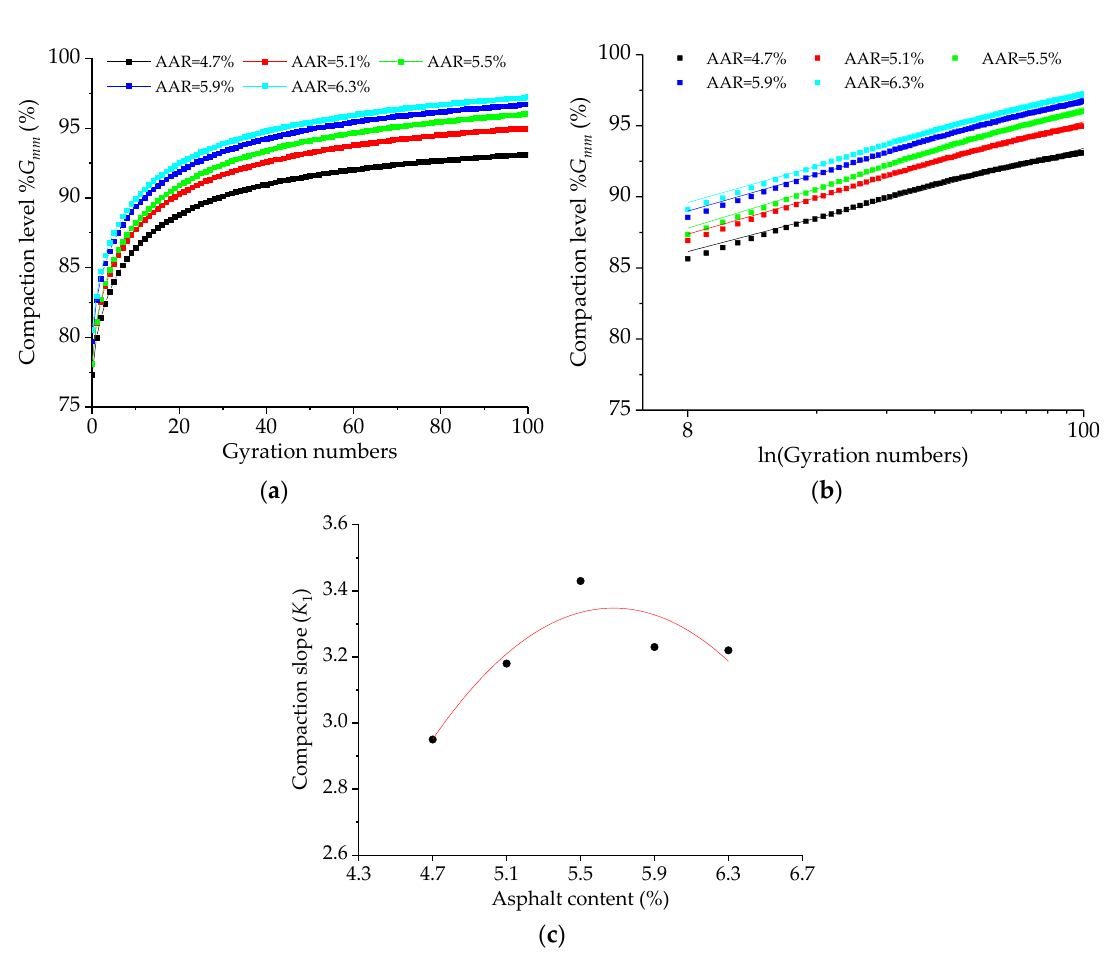
Figure 10. The compaction characteristics of SGC specimens with basalt fiber: ( a ) compaction curve, ( b ) compaction level during N ini → N des , and ( c ) K 1 value.